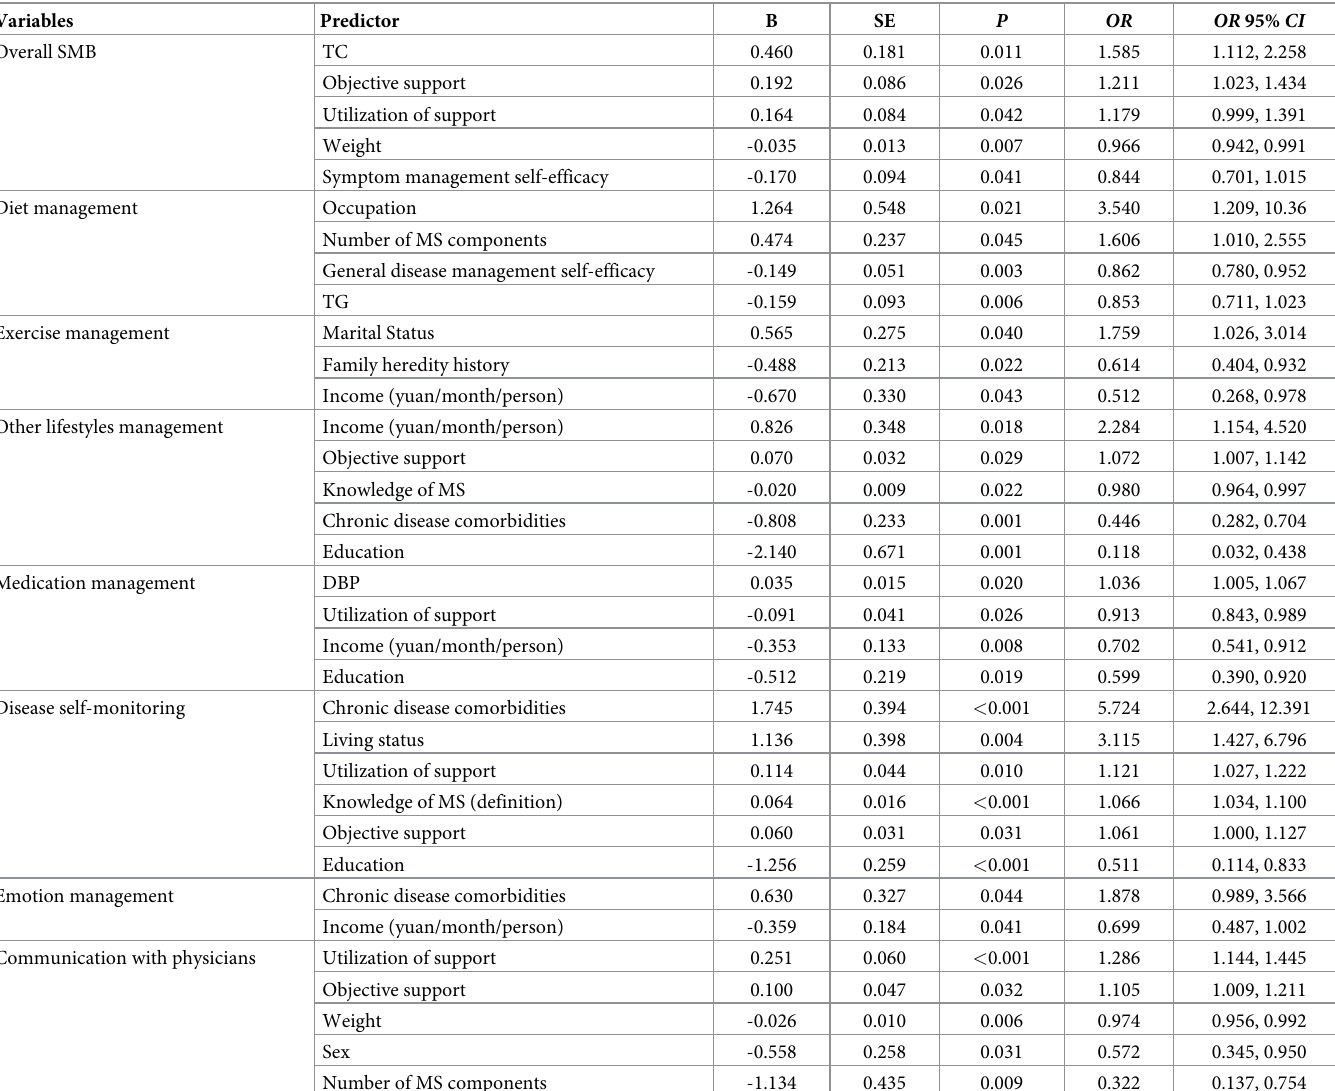
Table 3. Multi-factor analysis of health self-management behaviour ( n =